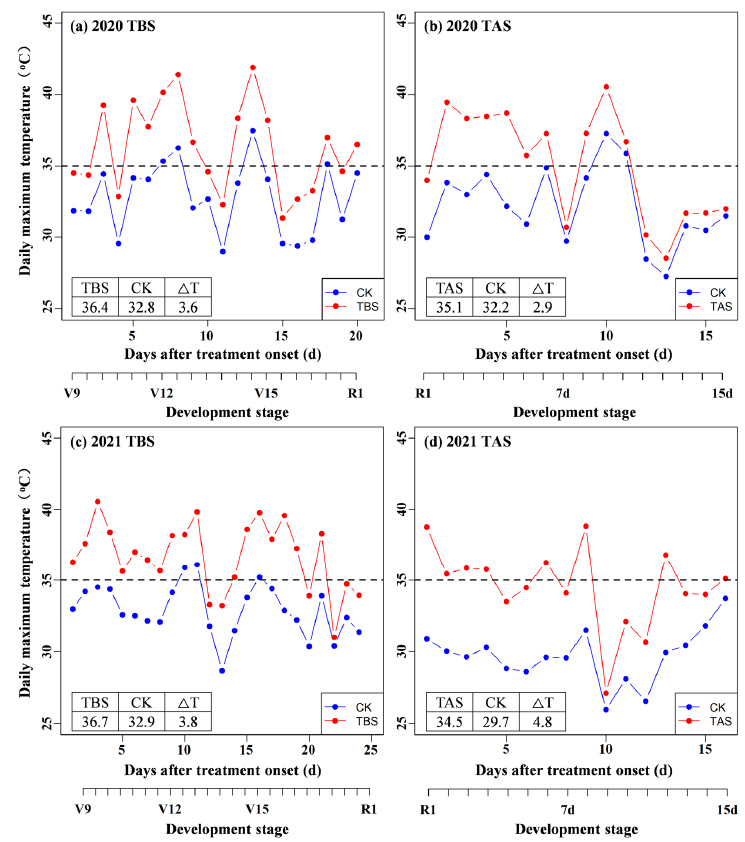
Figure 1. Daily maximum temperature during the key development stages under heat stress treat- ments in 2020 ( a,b ) and 2021 ( c,d ). TBS: Heat stress treatment before silking (V9-R1); TAS: Heat stress